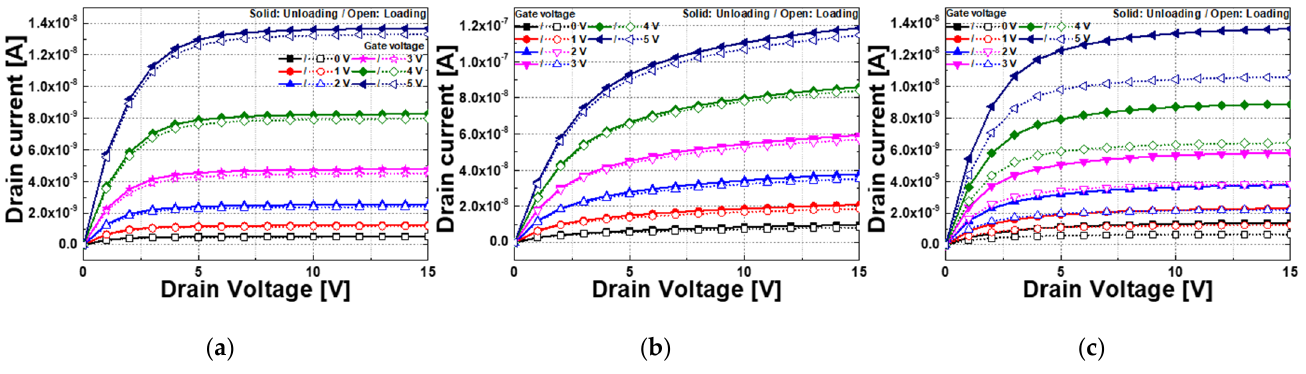
than the others, and in all types, as the gate voltage decreased, the response current ratio increased. The cause of this will be discussed in Section 3.3.